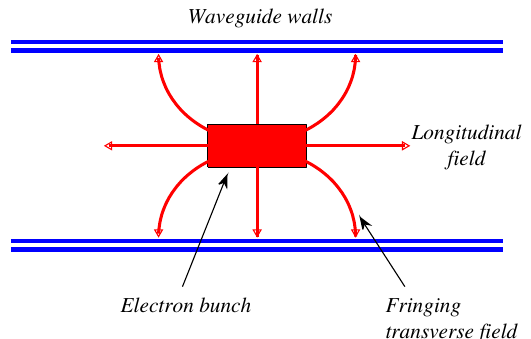
FIG. 1. (Color) Schematic illustration for fringing